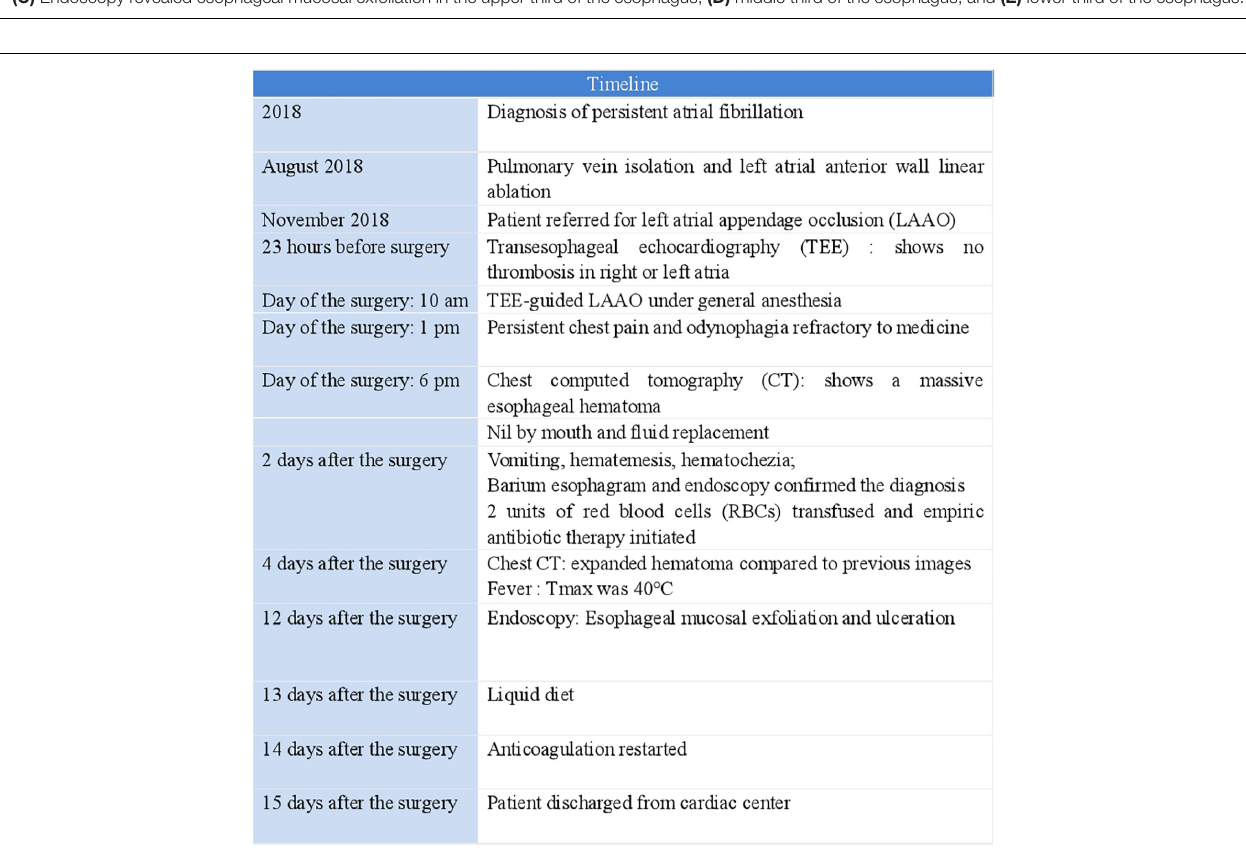
FIGURE 1 | (A) Sagittal chest computed tomography (CT) image reconstruction showed the hematoma extending from the entrance of the esophagus to the gastroesophageal junction (yellow arrows). (B) Axial chest CT image reconstruction showed the hematoma occupying more than half of the lumen (yellow arrow). (C) Endoscopy revealed esophageal mucosal exfoliation in the upper third of the esophagus, (D) middle third of the esophagus, and (E) lower third of the esophagus.